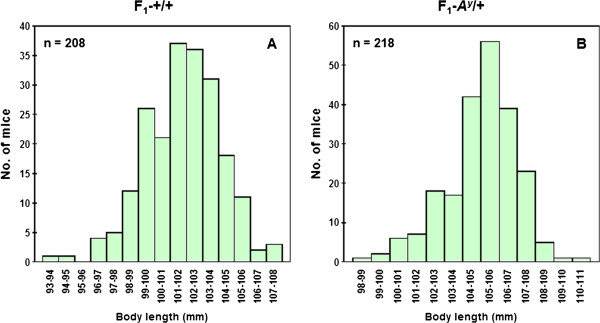
The distribution of body length in F1-+/+ (A) and F1-Ay/+ (B) hybrids.